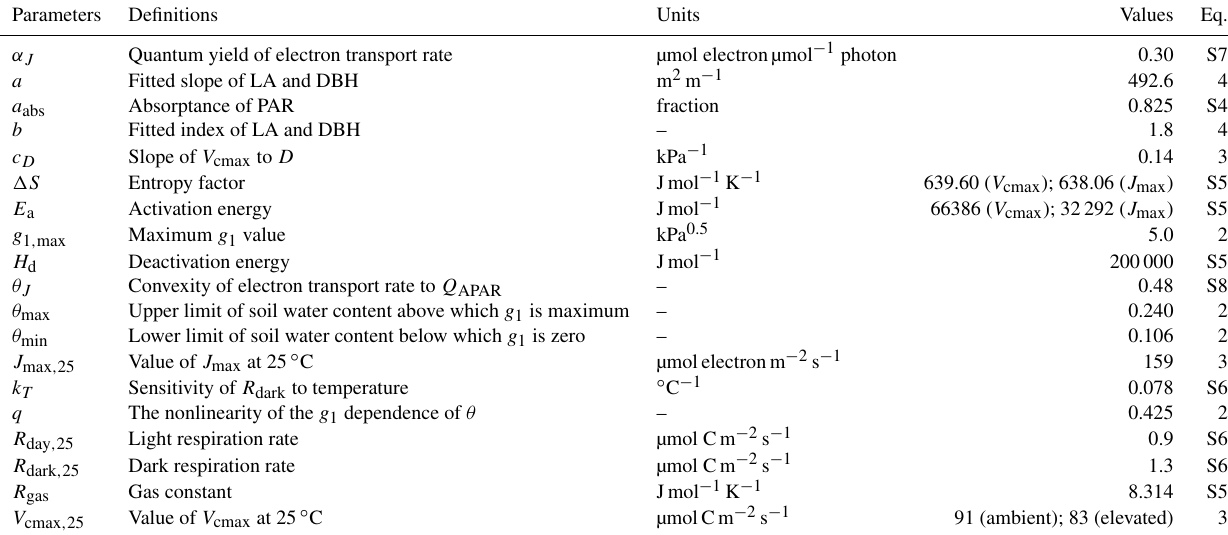
Table 1. Summary table of parameter definitions, units, and sources used in this study.